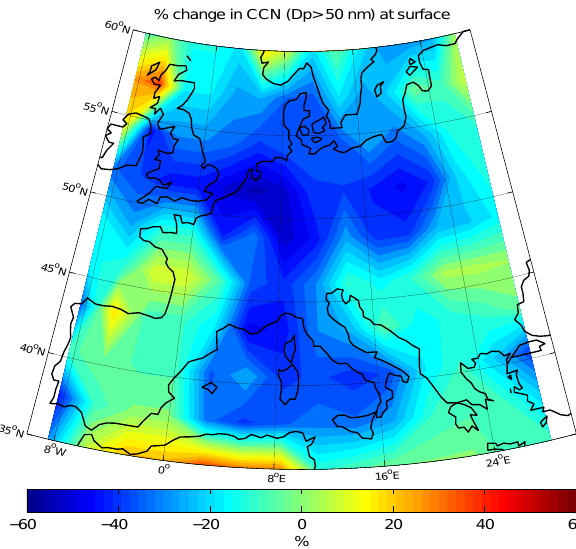
Relative change in model predicted potential CCN concentrations when the standard aerosol model set-up is replaced with the test model set-up.